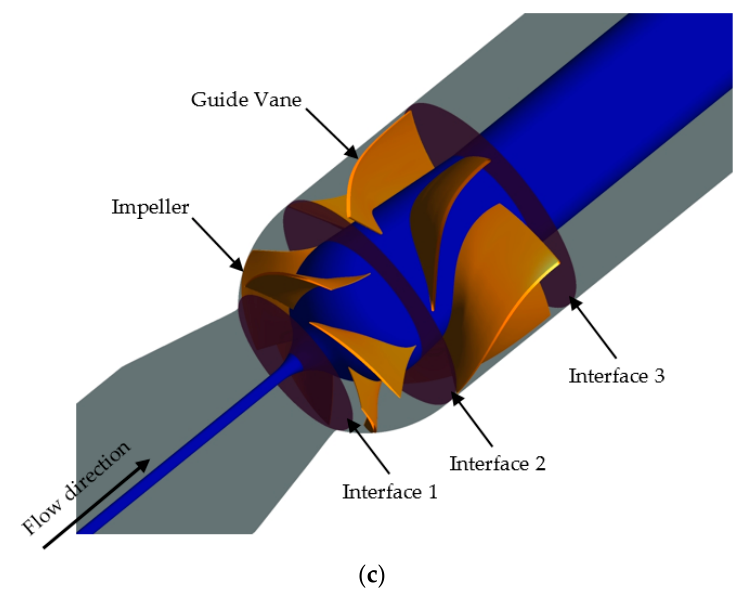
Figure 1. Impeller and c omputation domain of the mixed-flow pump. ( a ) Impeller from upstream; ( b ) Impeller from downstream; ( c ) Computation domain. Table 1. Parameters for the mixed-flow